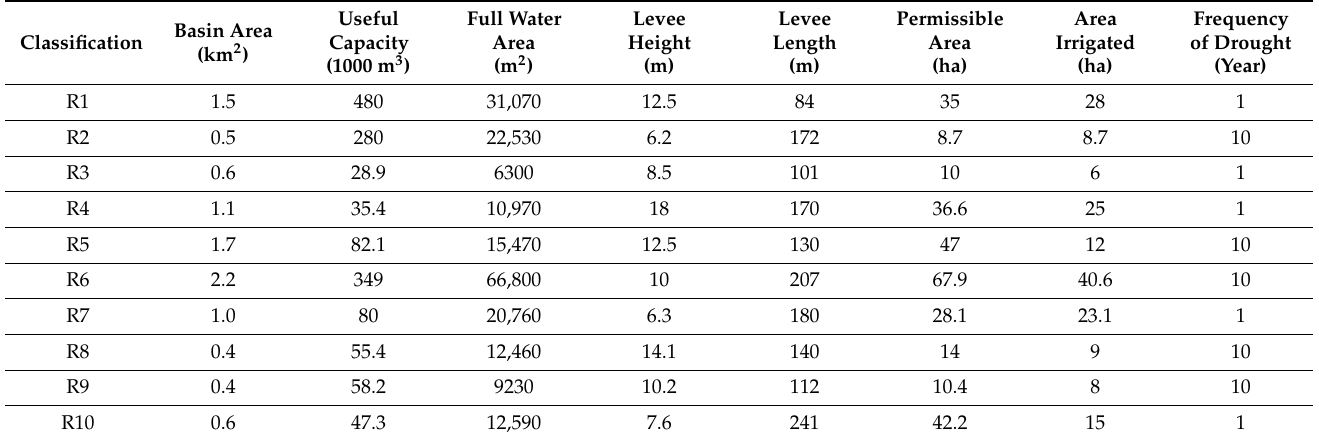
Table 7. Basic properties of ten